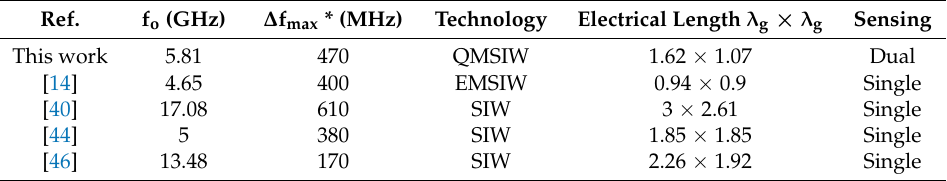
Table 4. Performance comparison between our proposed TM 02 -mode QMSIW resonator and other microwave dual/multichannel sensors.